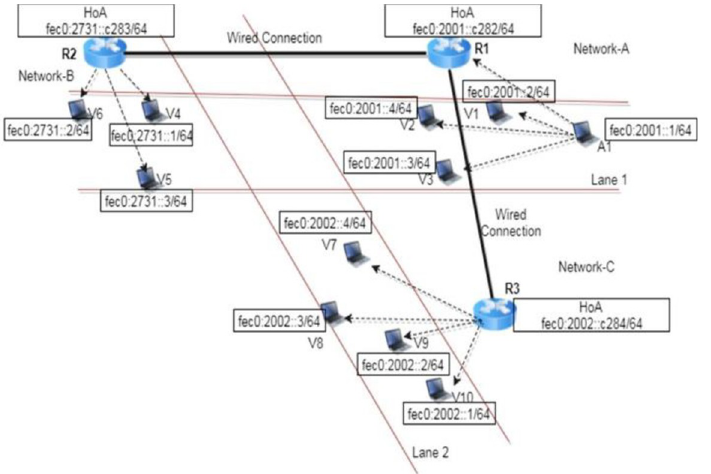
Fig 7. An experimental prototype design of the proposed